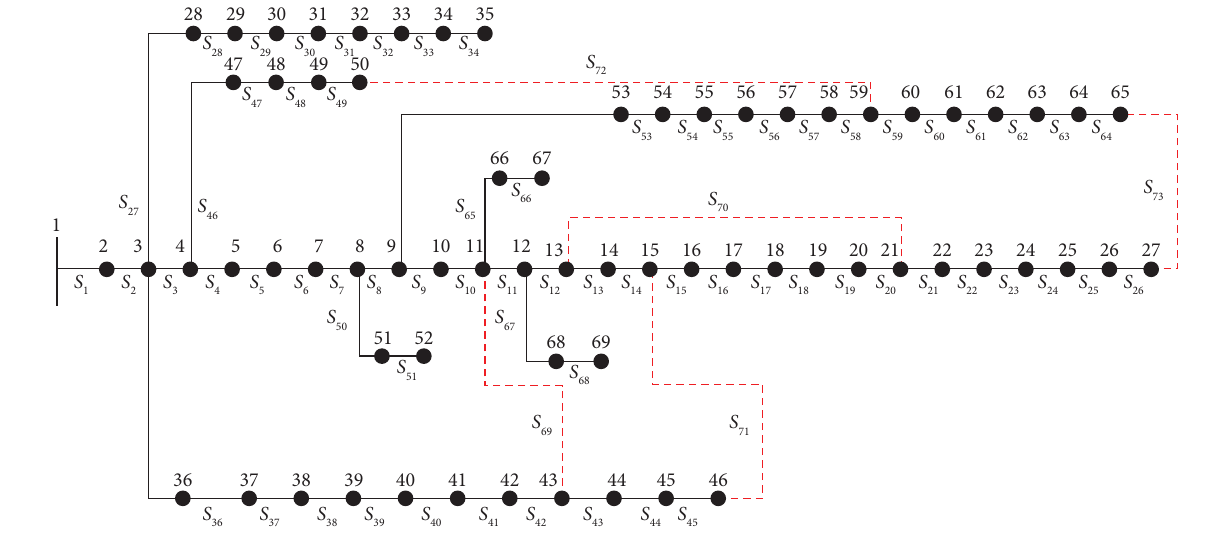
Figure 5: 69-bus IEEE system used in this work. Table 1: Te results and comparison among the scenarios for the IEEE 33-bus